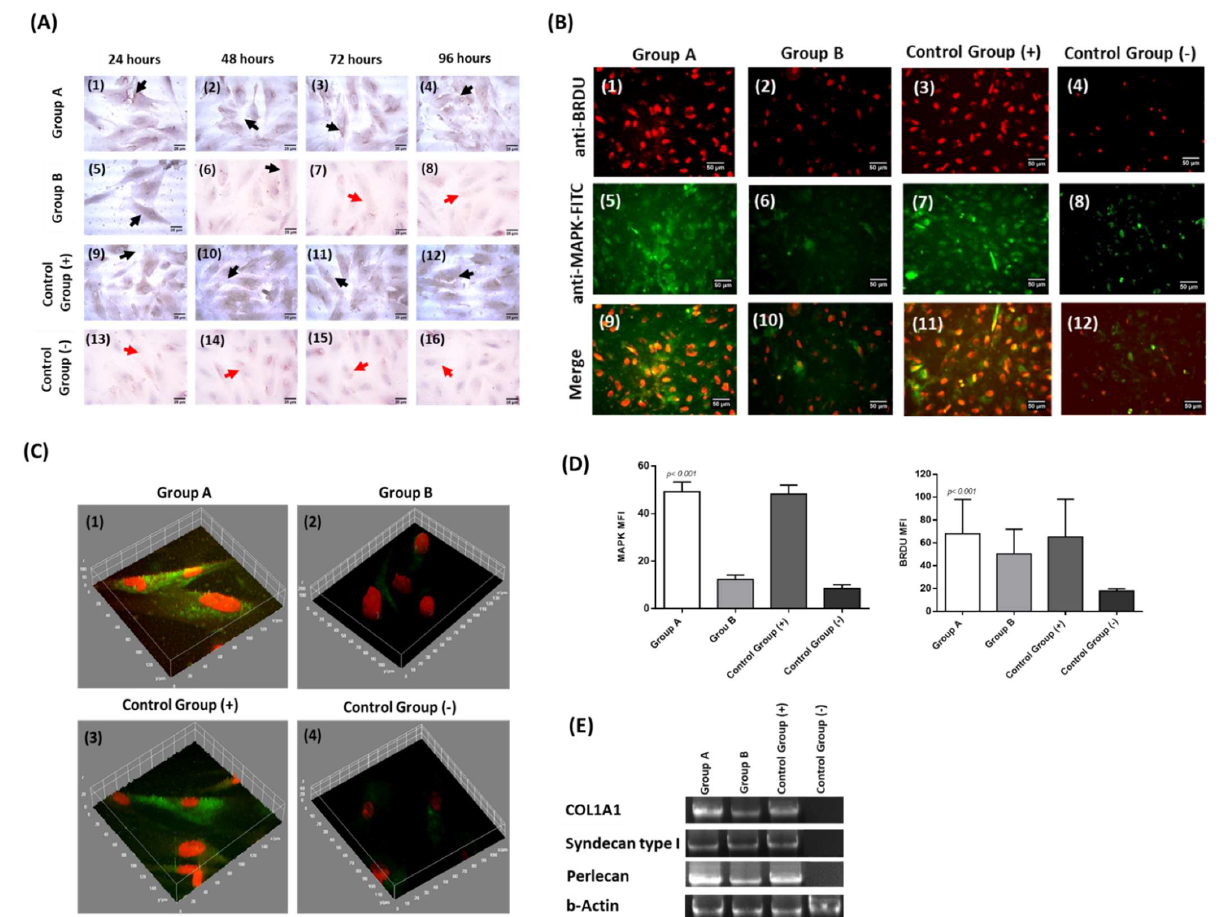
Figure 4. Immunostaining and gene expression analysis of CECs. Immunohistochemistry against MAP kinase in CECs of all groups ( A ). Specifically, differences in MAP kinase expression levels were detected between groups A (A1–A4), group B (A5–A8), positive control group (A9–A12) and negative control group (A13–A16). Black and red arrows in images A1–A16 indicated the presence and absence of MAP kinase, respectively. All images were acquired with original magnification 40x and scale bars 25 μm. Performance of indirect immunofluorescence against MAP kinase in combi- nation with BrdU in CECs ( B ). Indirect immunofluorescence against MAP kinase and BrdU in CECs of group A (B1, B5, B9), group B (B2, B6, B10), positive control group (B3, B7, B11), and negative control group (B4, B8, B12). All images were acquired with original magnification 20× and scale bars 50 μm. 3D reconstruction models of CECs obtained from the indirect immunofluorescence against MAP kinase and BrdU ( C ). 3D reconstruction images of CECs from group A (C1), group B (C2), positive control group (C3), and negative control group (C4). Mean fluorescence intensity of MAP kinase and BrdU of CECs from all study groups ( D ). Molecular analysis and detection of Col1A1, Syndecan type 1, Perlecan and b-Actin of CECs from all study groups ( E ). Group A: CECs cultured with α-ΜΕΜ supplemented with 20% v/v CB-PL), Group B: CECs cultured with α-ΜΕΜ supple- mented with 20% v/v CB-PPP, control group (+): positive control group, CECs cultured with com- plete culture medium, control group (−), negative control group: CECs cultured only with α-MEM.